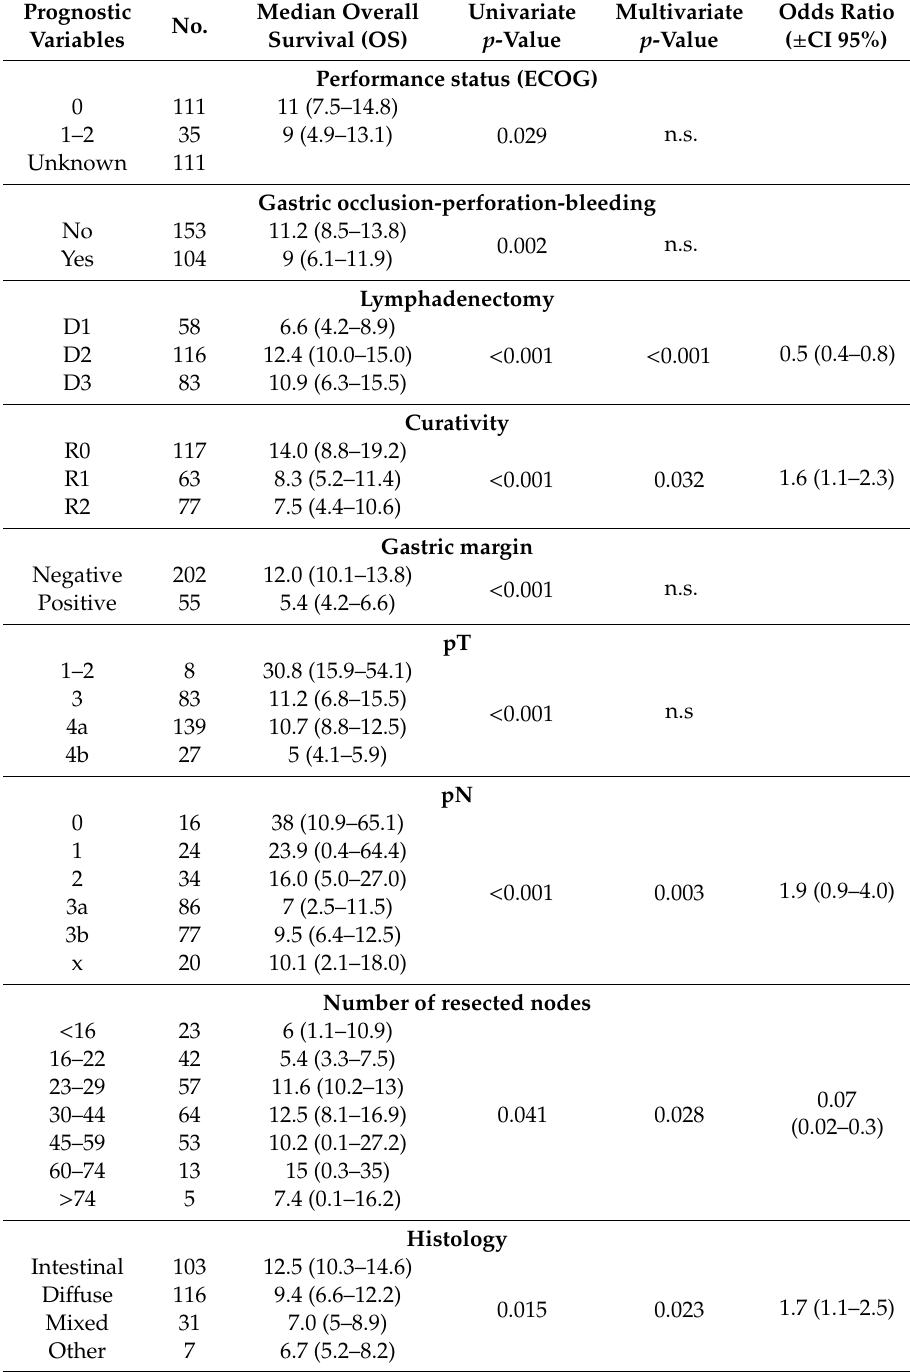
Table 4. Prognostic factors: univariate and multivariate analyses (257